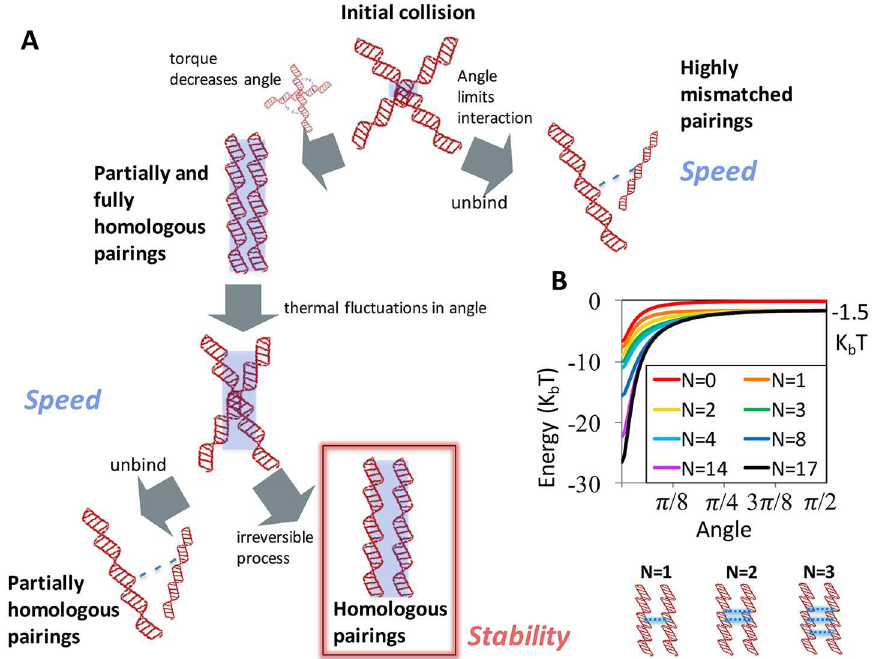
Fig 1. Model for interactions between dsDNA molecules. (A) Schematic of our model for multi-stage kinetic proofreading. Two DNA molecules(modeled as rigid rods) initiallycollideat a finite angle. The angle limits contact betweeninteraction sites and ensuresthat highly mismatched pairingsrapidly unbind irreversibly. Meanwhile,pairingswith roughly 4 or more matching sites flankingthe collisionsite experience an attractive torque that draws them into a more deeply bound, parallelstate. Partially homologous pairingsthat reach this deeply boundstate are destabilized by diffusive fluctuations in angle, which allow pairingsto re explore larger angles,from which point irreversible unbinding is faster. These fluctuations providefurther speedby allowinga given stringencyto be attainedfaster. Finally, pairingsthat remain bound for a minimum amount of time are irreversiblystabilized,ensuringstability for homologs. In this diagram, the blue shading indicatesthe approximate lengthover which pairingsinteract. (B) Energy as a function of angle for pairs of rods with a variablenumberof continuous matched sites flanking the collisionpoint, N . Examplediagramsof pairingswith N = 1, 2, and 3 are shown below the plot, with the blue, dashed lines indicatingattractive interactions betweenmatched pairs of sites. The attractive energy per matched site is -1.5 k B T , marked on the